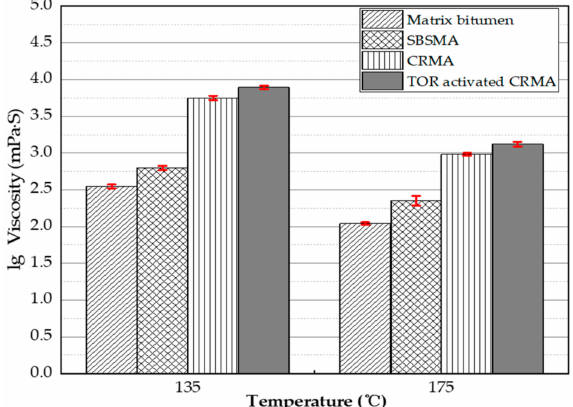
Figure 4. Viscosity of four binders on unaged asphalts.